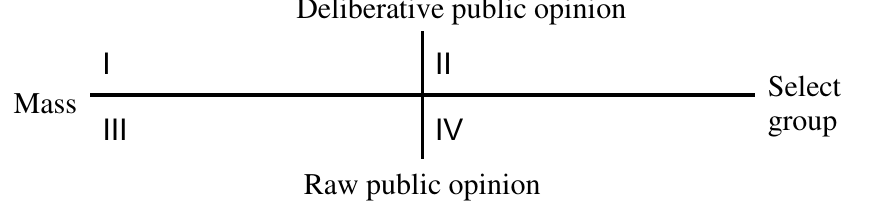
Table 1. Categories of public